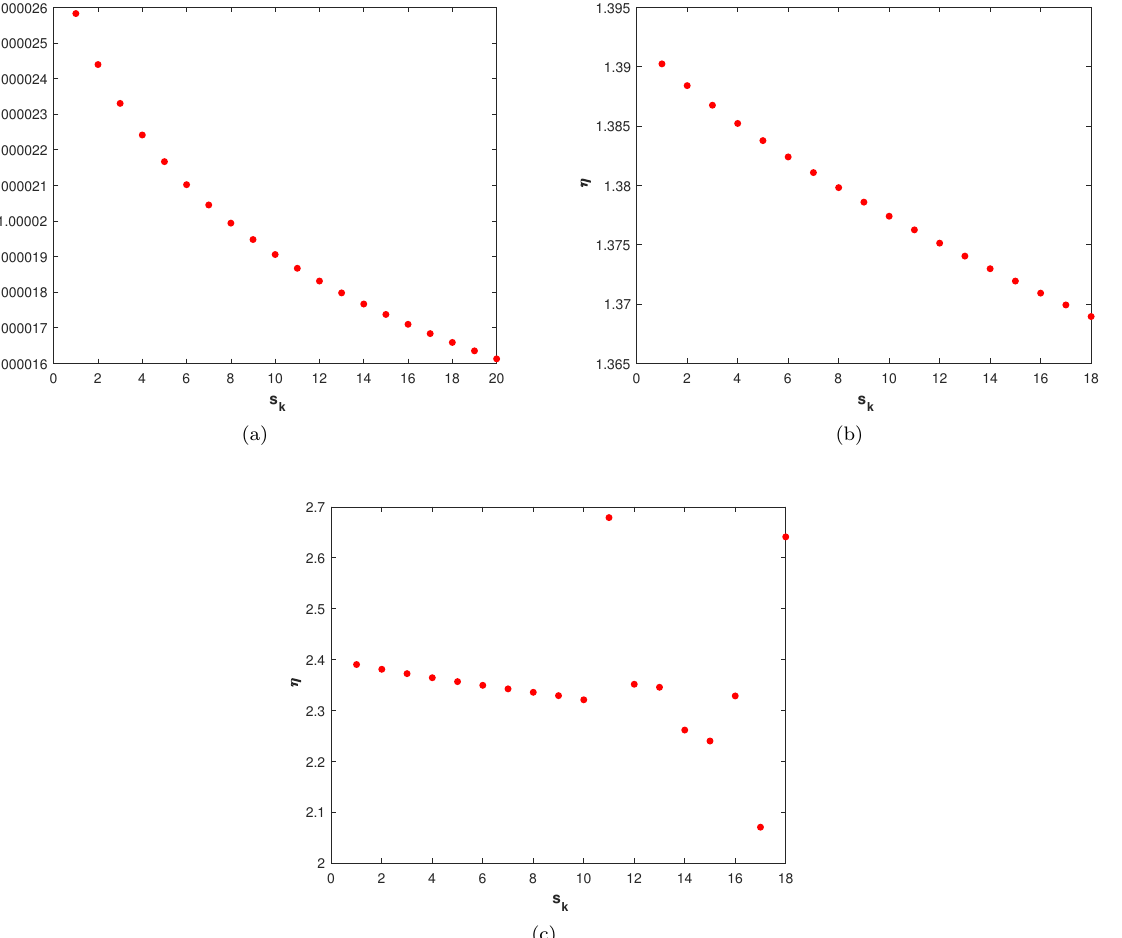
for (a) problem 1 (b) problem for ( a ) problem 1; A A